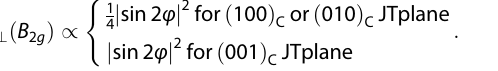
Figure 3 and Supplementary Fig. 1 show the experimental results from the angle-resolved Raman spectroscopy of the B 2g mode for three representative positions, which are indicated by the Raman maps represented above the polar plots. mode were normalized by those of the A g mode. Figure 3a – c (Fig. 3d – f) show the polar plots obtained in the parallel (cross) polarization geometry. The scattered data from 0° to 180° are experimental data (solid circles) and the data from 180° to 360° (empty circles) are a repetition of that from 0° to 180°, to provide a better comparison between the polar diagram and our fi tting curves. In the bright region of the Raman map, the intensity has a two- fold symmetry, with a spindle shape where the intensity is maximized when the light polarization is aligned along the [100] C direction (Fig. 3a). In the dark region, the polar plot in Fig. 3b has a similar shape to the one in Fig. 3a but the graph is rotated by 90°. are from the (100) C or (010) C JT planes, respectively. Meanwhile,